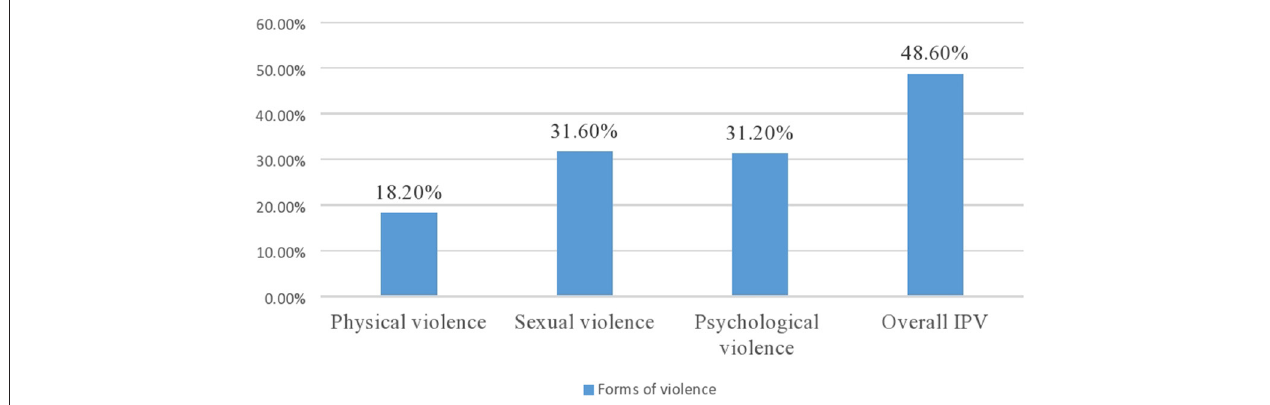
FIGURE 1 | Forms of intimate partner violence during pregnancy in Gondar city, northwest Ethiopia,